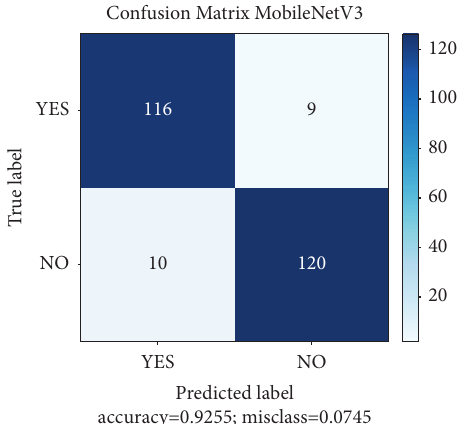
Figure 15: MobileNetV3 network architecture accuracy based on